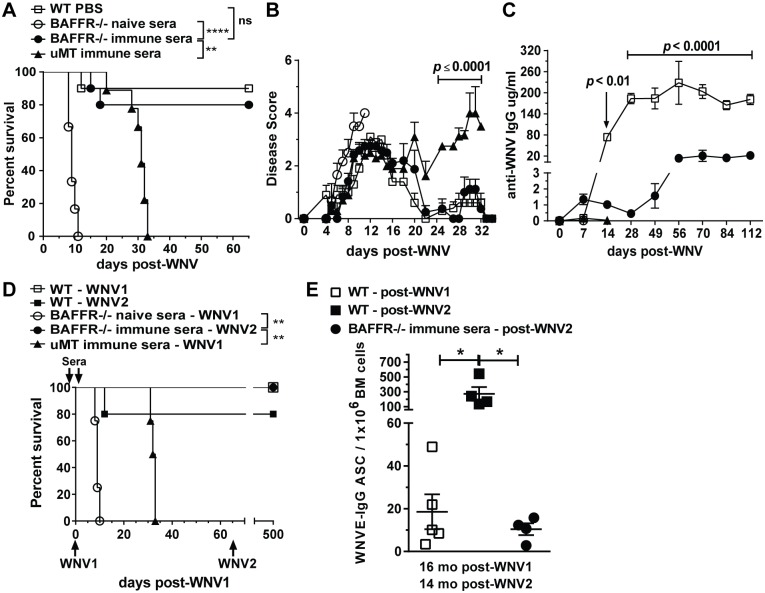
Transfer of WNV immune sera induces long term protection against WNV in BAFFR-/- but not μMT mice.A-E, Heat-inactivated sera obtained from WT mice infected for 5 to 14 days with WNV were inoculated into BAFFR-/- and μMT mice 1 day prior and 1 day after WNV infection (See Methods). In D and E, 65 days after the first WNV infection (WNV1) mice were re-challenged with 102 PFU of WNV-TX (WNV2) and 14 months later bone marrows from surviving mice were harvested to measure long-lived WNV E-specific Ab secreting cells (ASCs) by ELISPOT (E). Mice were monitored for survival (A and D) and clinical signs of disease (B). C, WNV E-specific IgG in sera from WT, BAFFR-/- and μMT mice at the indicated time points after WNV infection was detected by ELISA. A-C, graphs summarize data from two independent experiments; N = 10 for WT mice given PBS, BAFFR-/- mice inoculated with WT immune sera and μMT mice inoculated with WT immune sera, and N = 6 for BAFFR-/- mice inoculated with WT naïve sera. In D, data are from one experiment; N = 5 for WT mice infected once (WNV1) or two times (WNV2); N = 4 for BAFFR-/- mice inoculated with WT naïve sera, BAFFR-/- mice inoculated with WT immune sera and infected twice (WNV2) and μMT mice inoculated with WT immune sera and infected once (WNV1). In A and D statistics were performed using a log-rank test for significance, **, p<0.01; ****, p<0.0001; n.s., not significant. The multiple t test Holm-Sidak method was used to compare in B, BAFFR-/- mice that received immune sera and μMT mice that received immune sera; and in C, WT mice that received PBS and BAFFR-/- mice that received immune sera. In E data are represented as means ± SEM from one experiment and statistics were determined by one-way ANOVA corrected with Holm-Sidak multiple comparison post-test, * p<0.05.